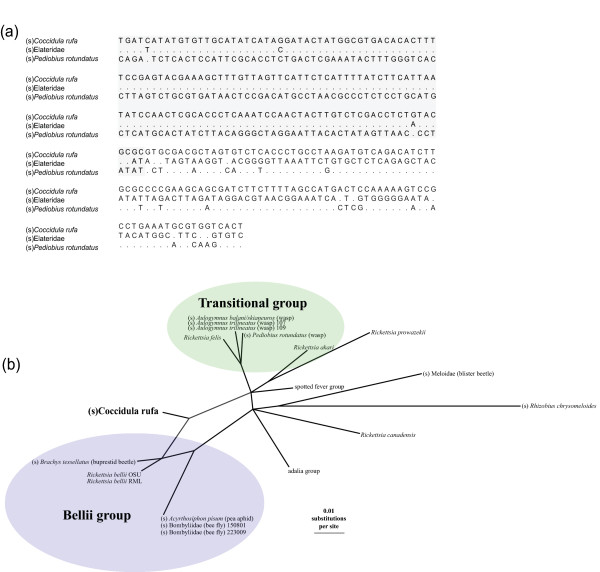
Sequence alignment and hybridisation network showing the symbiont of Coccidula rufa to be a recombinant. (a) Alignment of concatenated genes atpA, coxA, gltA, 16S showing just polymorphic sites. Nucleotides that are identical to the C. rufa sequence are shown as a dot. The (s)C. rufa sequence of atpA and coxA (shaded) are most similar to (s)Elateridae in the bellii group, while the gltA and 16S sequences (unshaded) are most similar to (s)Pediobius rotundus in the transitional group. (b) A hybridisation network of the concatenated sequences of atpA, coxA, gltA and 16S. A neighbour-net split network was generated and splits were then filtered by weight to include only the (s)C. rufa split. A hybridisation network was then performed on the split network to provide an explicit example of descent from the two different groups.